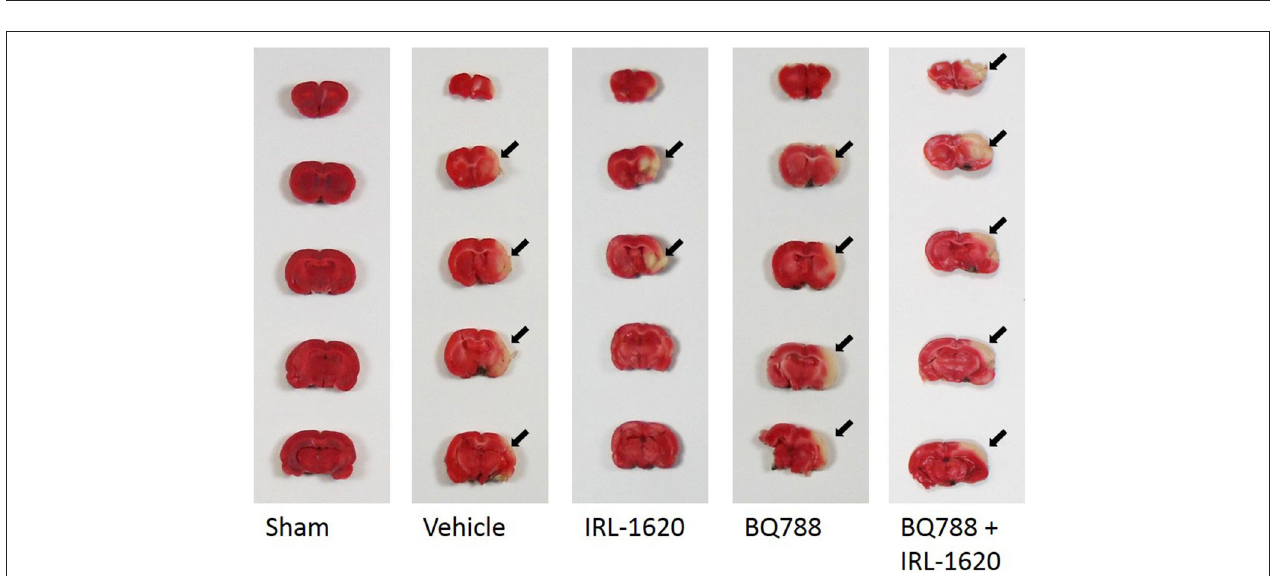
FIGURE 4 | Representative images of infarct. Two-mm coronal sections of brains were stained with 2% 2,3,5-triphenyltetrazolium chloride (TTC) to visualize the infarct area. Arrows denote area of infarct. Red, normal tissue; white, infarcted tissue.